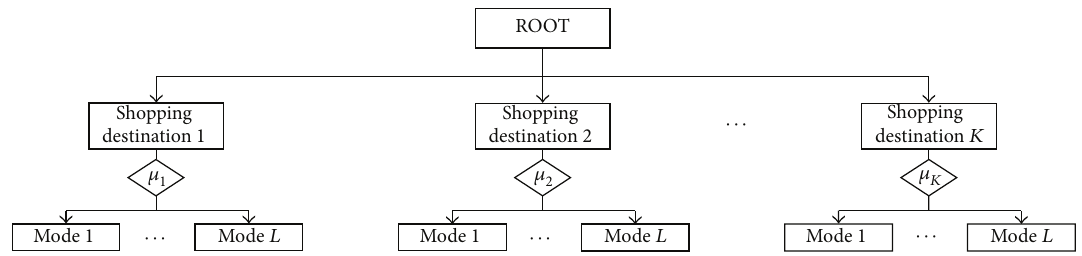
Figure 2: Structure of two-level NL model, using nesting along shopping destination dimension.